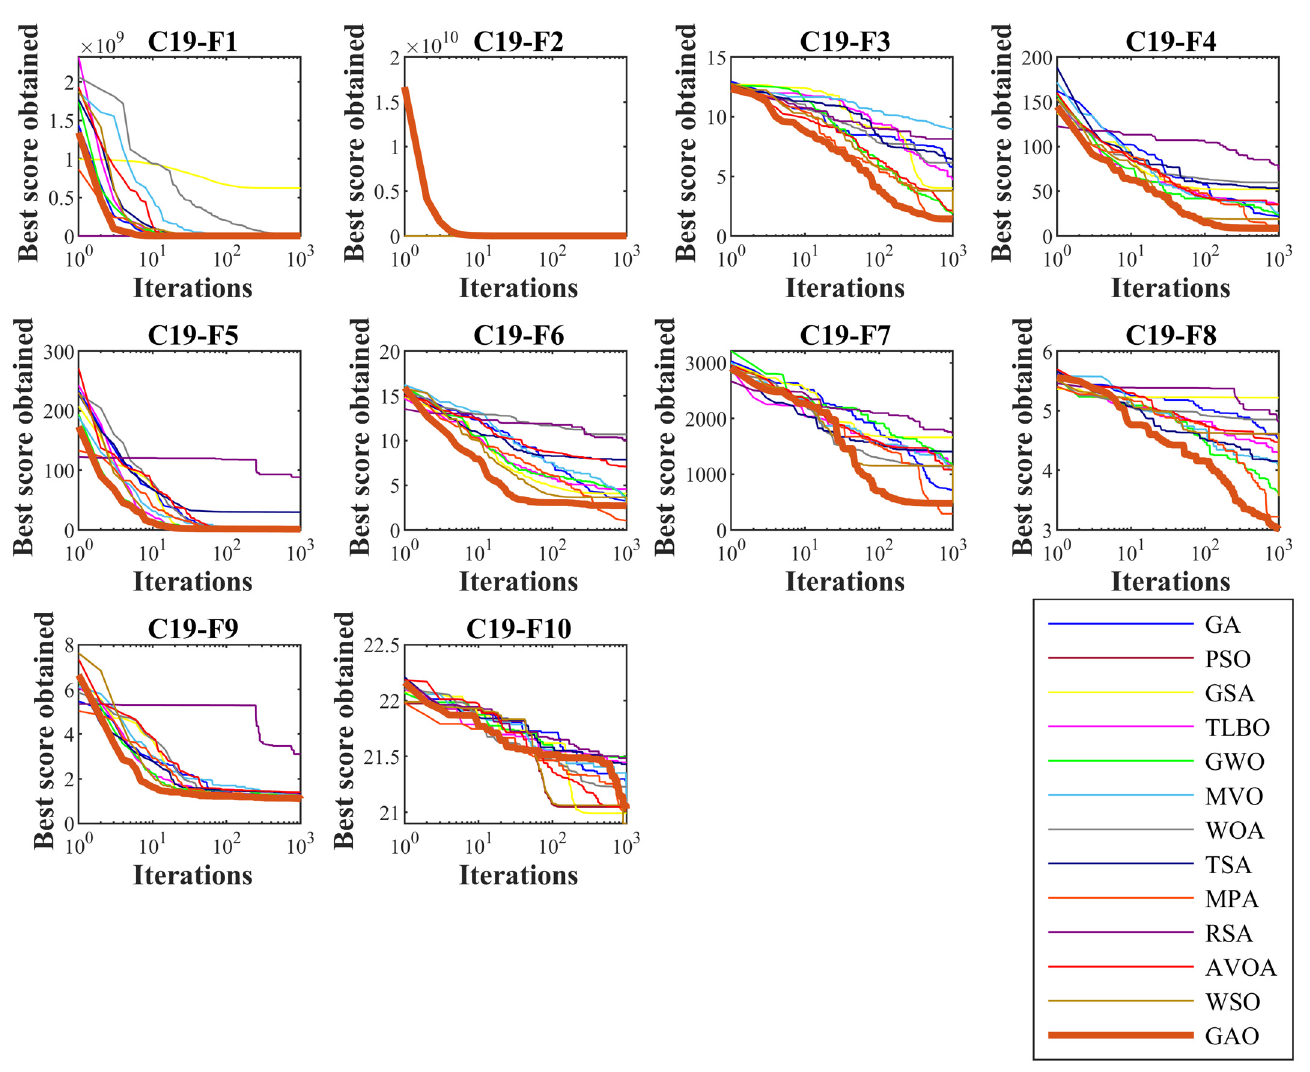
Figure 7. Convergence curves of GAO and competitor algorithms performance on the CEC 2019 test suite.